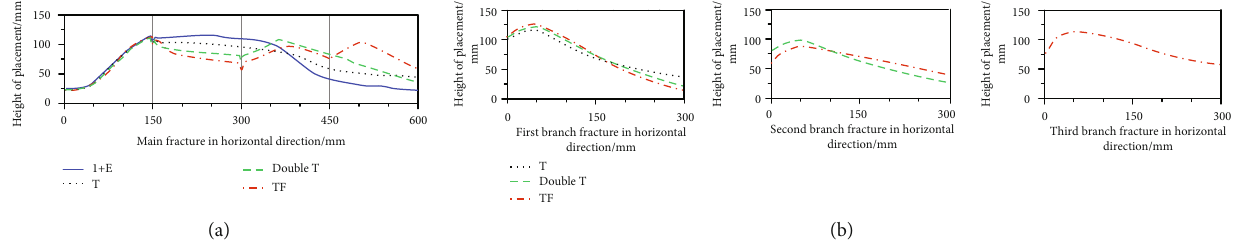
Figure 14: Proppant transport characteristics in the main fracture (a) and branch fractures (b) with di ff erent fracture Table 3: In fl uencing factors and sensitivity factors of proppant transport characteristics in complex fractures. In fl uencing factors